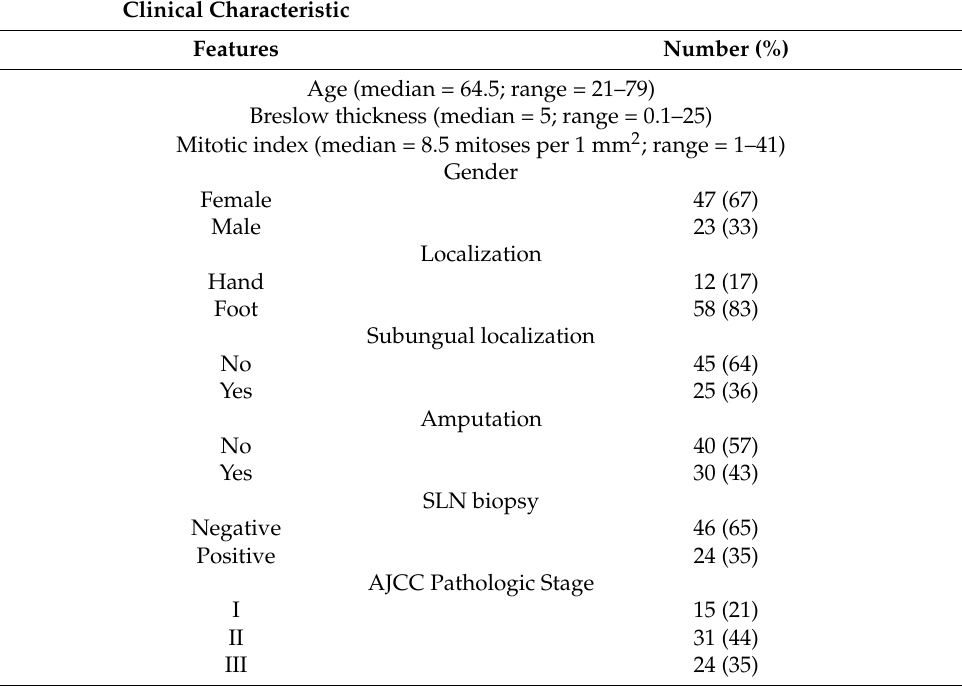
Table 1. Baseline clinical and histopathological features of melanoma cases. Clinical